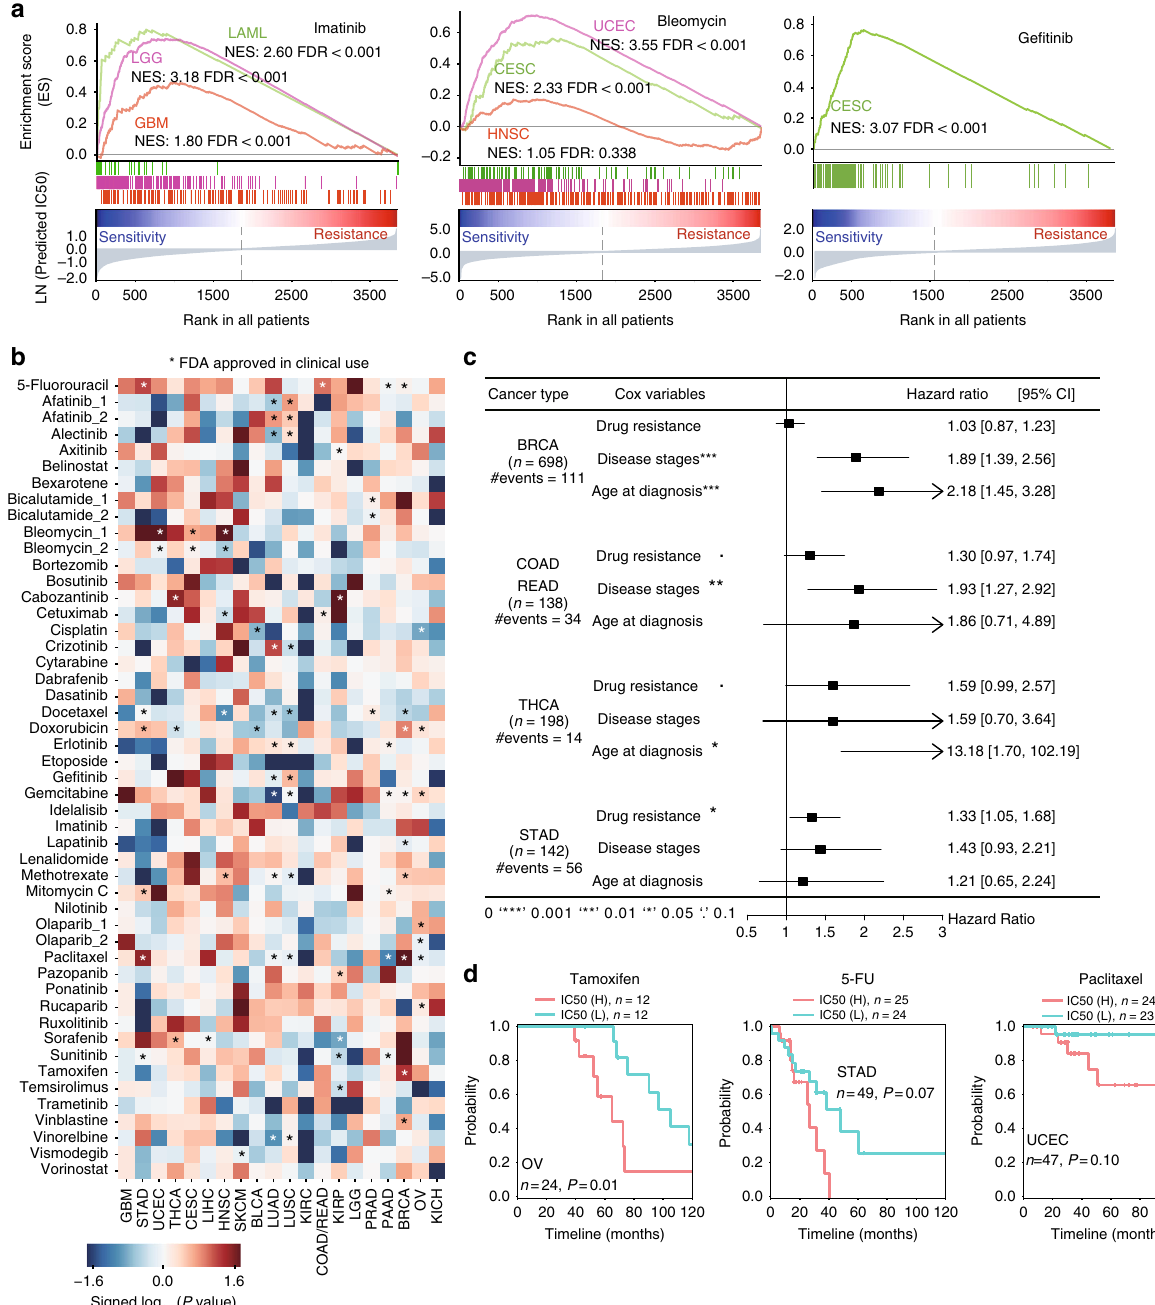
Fig. 4 LncRNA-based EN-prediction models predict drug response in patient tumors. a Imatinib (left), bleomycin (middle), and ge fi tinib (right) were predicted to be sensitive in FDA approved or yet-to-be approved cancer types. b Different overall survival rates between patients with different predicted responses to each of the 49 FDA approved cancer drugs in individual cancer type. Blue and red represented hazard ratio by the univariate cox regression model. The asterisks indicate the drugs that are approved by FDA for corresponding cancer types. c Forest plot of multivariate Cox regression analysis of “ Drug resistance ” , “ Stage ” and “ Age at diagnosis ” on patient survival in four cancer types. d The Kaplan – Meier curves of overall survival for OV, STAD, and UCEC patients who received corresponding treatments. The patients were segregated by median predicted = 1.40, p = 0.02) and CRC (Colorectal Cancer, HR = 1.38, p = line chemotherapy (Supplementary Data 5) that are approved by FDA for each cancer type (see Methods section). Using this